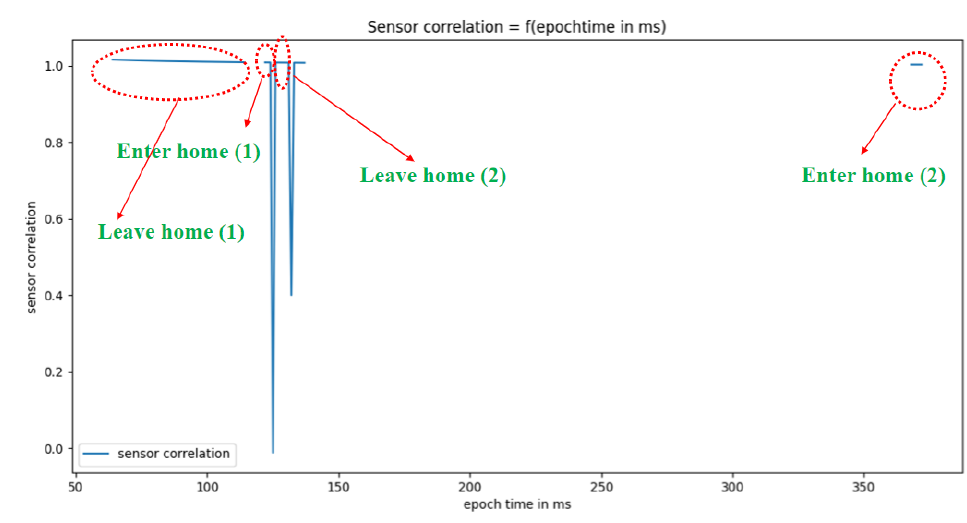
Figure 16. Segmentation of the activities leave home and enter home.